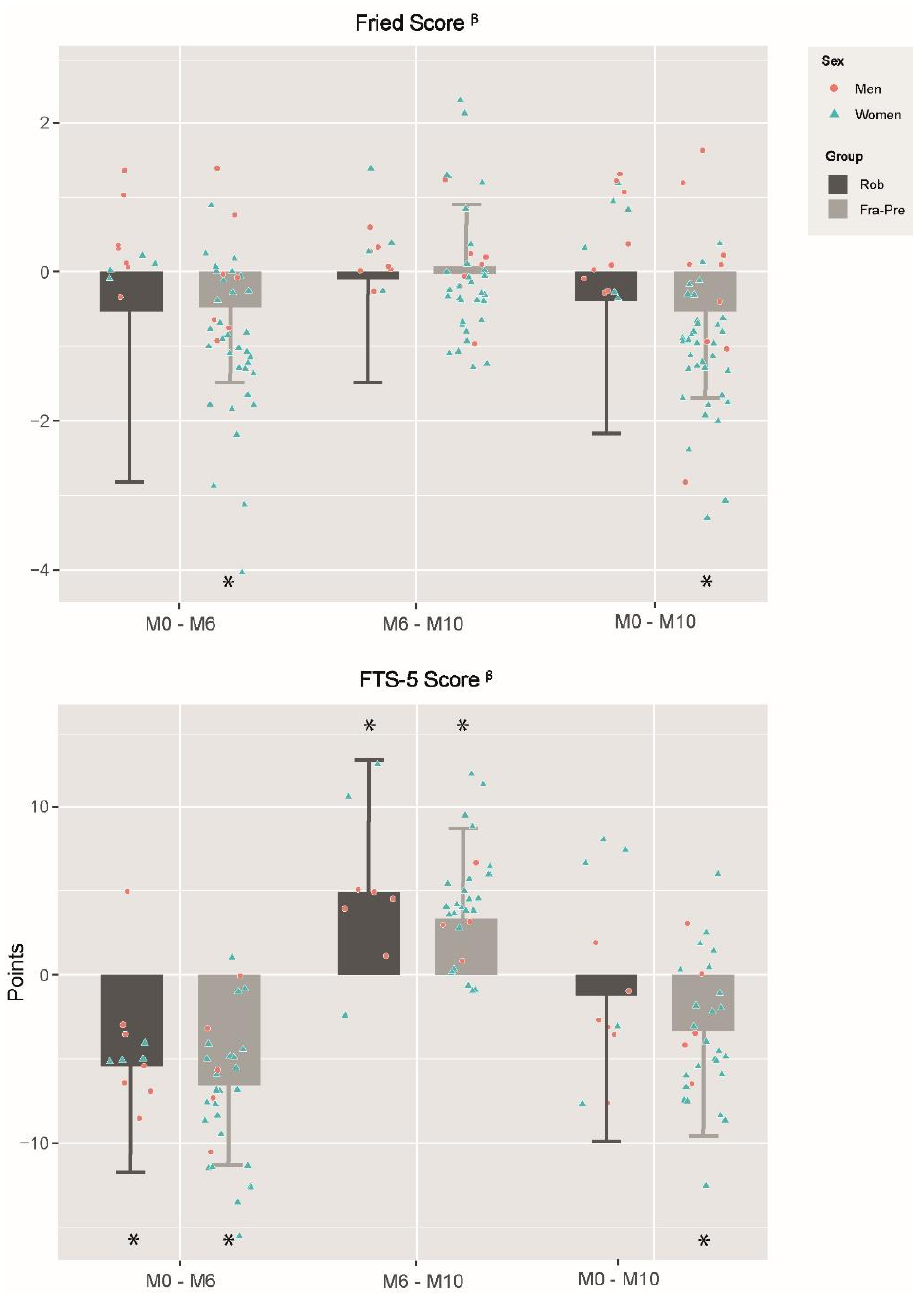
Figure 4. Changes in frailty levels between and within training subgroups in different evaluation periods. M0 – M6: changes between baseline and 6th month; M6 – M10: changes between 6th and 10th month; M0 – M10: changes between baseline and 10th month; FTS-5: Frailty Trait Scale of 5 items; PRE-FRA: Prefrails and frails participants of training group; ROB: Robust participants of training group; TRAIN: training group; *: significant differences within groups changes; : negative changes represent frailty diminution; Differences were obtained by linear mixed models adjusting by baseline values, gender and age; Statistical significance was set at p < 0.05.